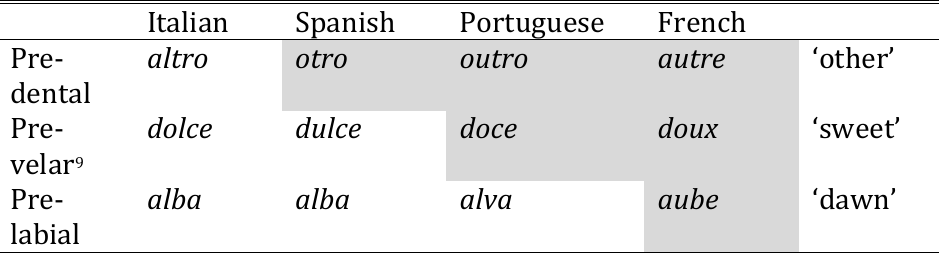
Table 1: Continuum of /l/-­‐vocalization in the Romance languages. (shaded =